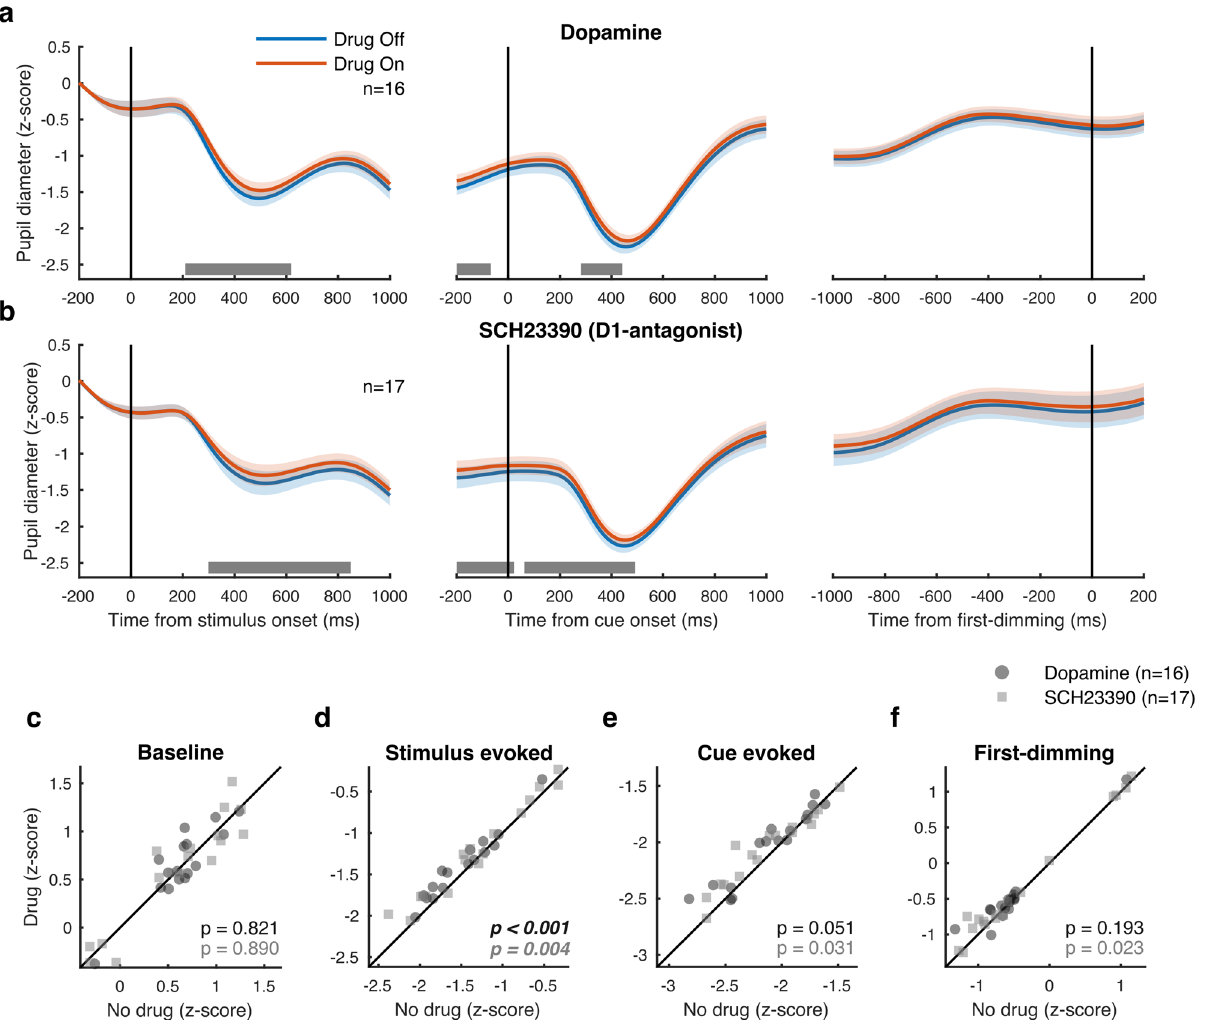
Figure 5. Modulation of pupil diameter by dopamine in parietal cortex. ( a ) Pupil diameter during sessions where dopamine was administered aligned to stimulus onset (left), cue onset (middle) and the first dimming event (right). The grey bar indicates the times where drug application brought about a significant difference in pupil diameter. ( b ) As ( a ) but for sessions where D1R antagonist SCH23390 was applied. ( c–f ) Average pupil diameter during pre-stimulus baseline period ( c ), after stimulus onset ( d ), after cue onset ( e ), and before the first dimming event ( f ). Shaded regions denote ± 1 SEM. Statistics: Wilcoxon signed rank test (FDR corrected). Statistics deemed significant after multiple comparison correction are displayed in italic and boldface